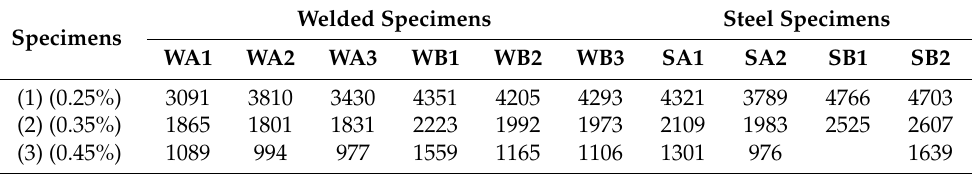
Table 3. Number of half cycles of welding material and steel.